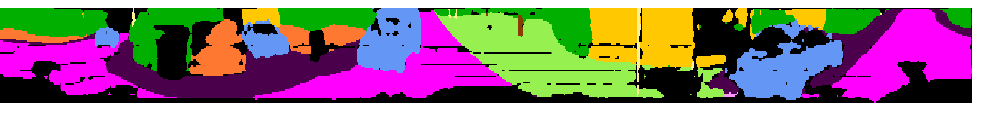
Figure 11. Network result.